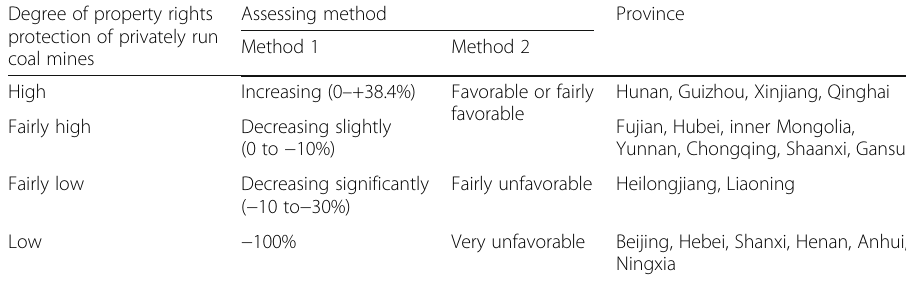
Table 4 Classification based on the degree of property rights protection in privately run coal